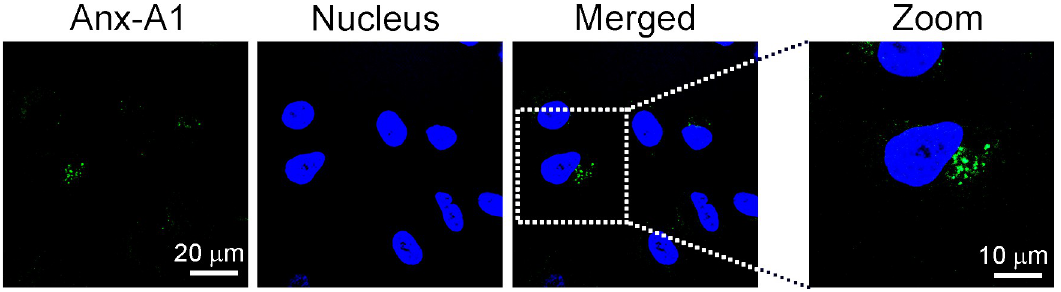
Fig 1. Anx-A1 can be detected on the surface of cells permissive for HSV-1 before infection. Mock-infected A549 cells were subjected to immunofluorescence staining with anti-Anx-A1 Ab before permeabilization. Nuclei were counterstained with